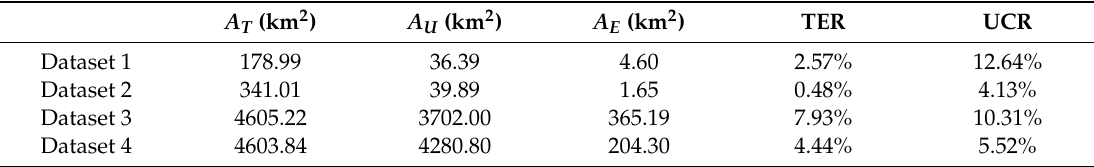
Table 1. Reliability of the final maps in the datasets. TER—total error rate; UCR—uncertainty contribution rate. Figure 9. Reliability evaluation of different error types: ( a,b ) total error rate (TER) and uncertainty contribution rate (UCR) of Datasets 1 and 2; ( c,d ) TER and UCR of Datasets 3 and 4.